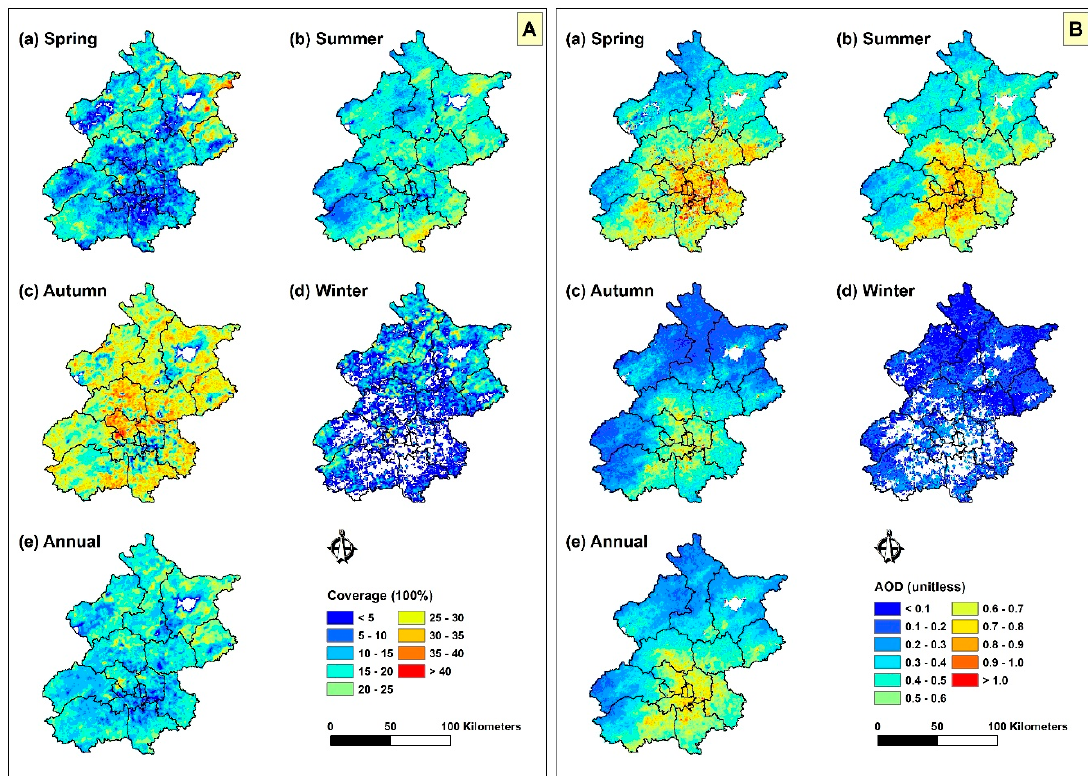
Figure 2. Seasonal-spatial distribution of VIIRS IP AOD ( A ) coverage and ( B ) average. ( a – e ) correspond to spring, summer, autumn, winter, and annual in subfigures ( A ) and ( B ).